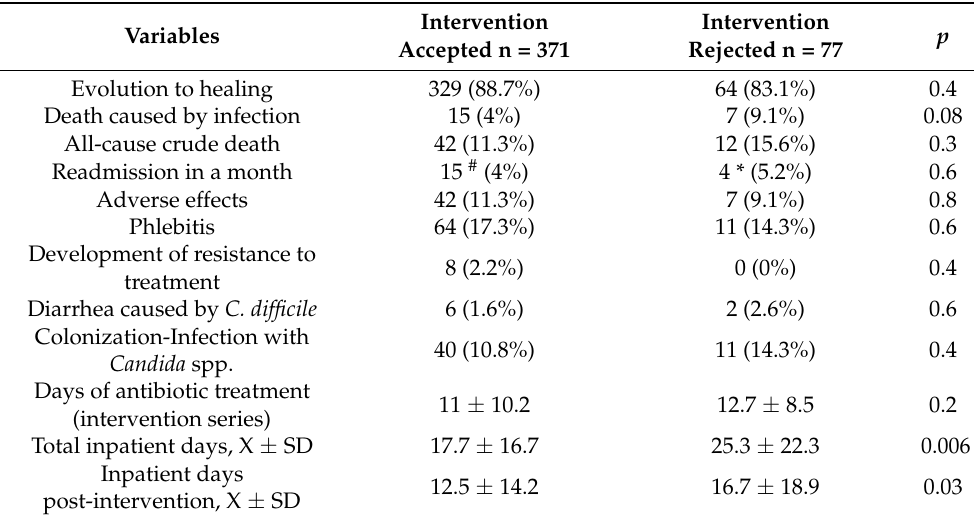
Table 2. Clinical results of patients with and without Acceptance of ASP recommendations. Years